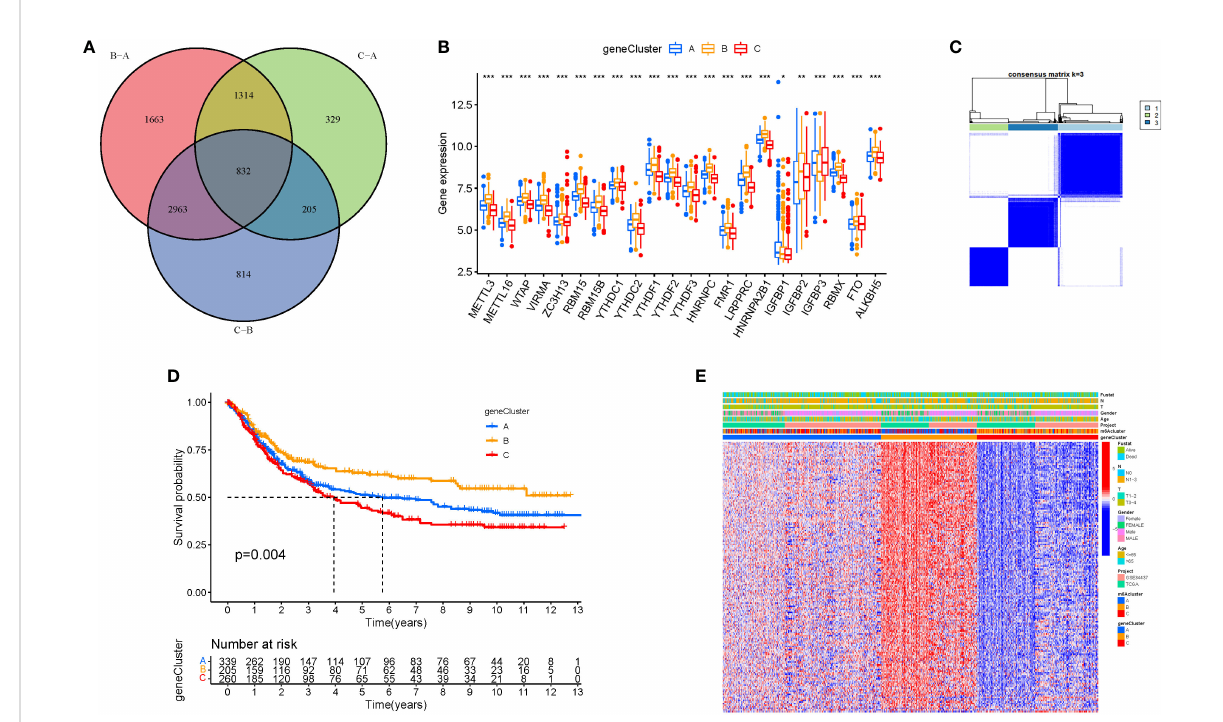
FIGURE 5 Cluster variance analysis and DEGs. (A) VNN (Correlation of differential expression of m6a gene among the three clusters). (B) Boxplot. (C) The consensus (When k was 3, intraorganizational links were strongest and intergenerational connections were weakest). (D) Kaplan-Meier OS curves (Cluster B had a greater survival rate). (E)